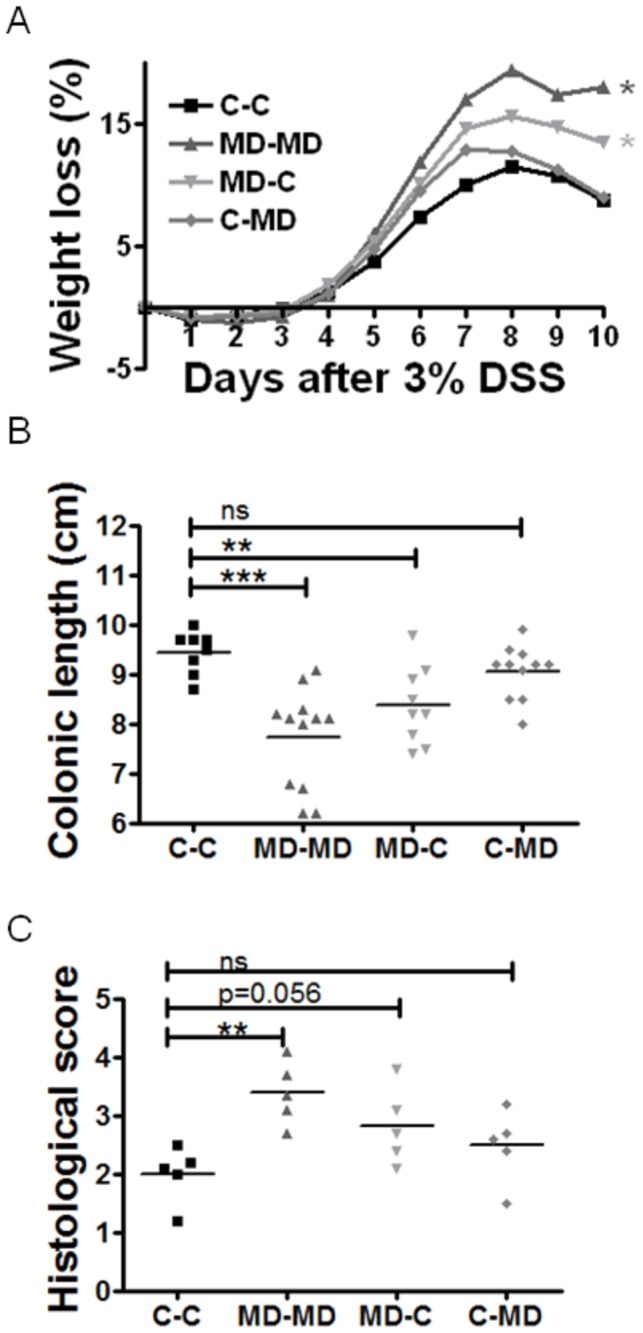
Prenatal MD supplementation is sufficient to worsen young adult male colitis.Dams were provided either a control (C) or methyl-donor (MD) diet before, during and following (lactation) pregnancy. Each litter was crossed fostered. Groups were designated as following: MD-MD if they had received MD diet in utero and lactation; C-C for control diet in utero and lactation; MD-C for MD in utero and control in lactation and the last group were C-MD that received control in utero and MD in lactation. Offspring were transferred to control diet at weaning (P21) and tested for susceptibility to colitis by 3% DSS exposure for 5 days in drinking water at P90. (A) The MD-MD and MD-C male mice showed significantly (*p<0.05) increased weight loss compared to the C-C. (B) Colonic lengths were significantly shorter (*p<0.05) in the MD-MD and MD-C compared to the negative control C-C. N=8-12 per group. (C) Histological severity of inflammation was consistent with the MD-MD group suffering a more severe colitis than control. There was a trend approaching significance for microscopically increased colitis in the MD-C group as well. N=5.